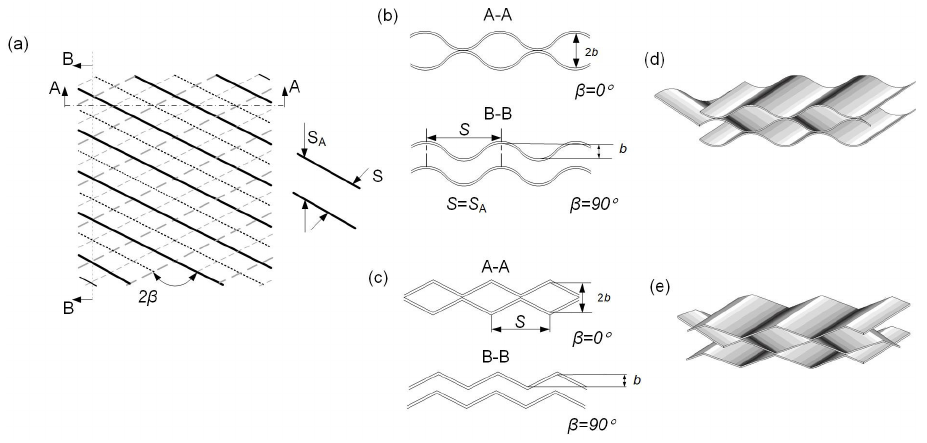
Figure 2. The main field of a channel between two corrugated PHE plates (schematically): ( a ) corrugations crossing; ( b , d ) sine-shaped corrugations; ( c , e ) triangle-shaped corrugations.